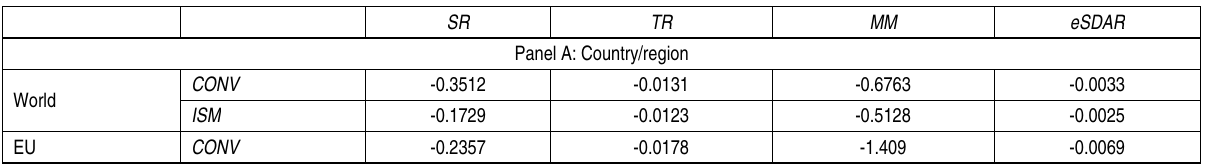
Table 10. Sharpe, Treynor, MM and eSDAR ratios during financial